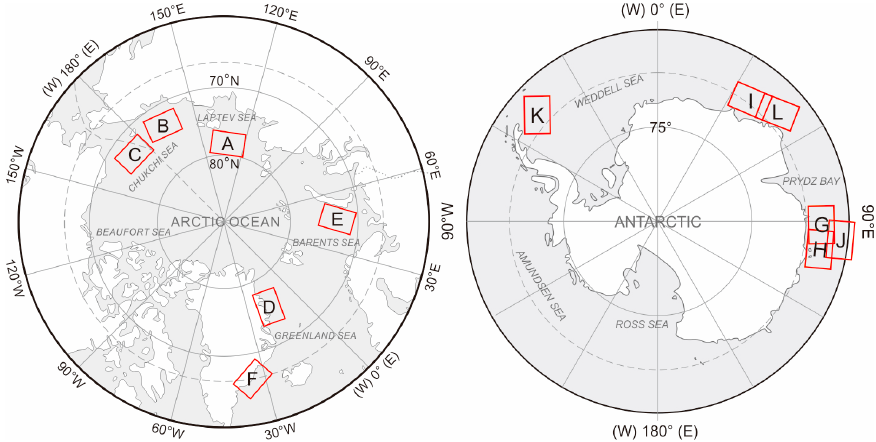
Figure 1. Location of the twelve moderate ‐ resolution imaging spectrometer (MODIS) scenes in Arctic and Antarctic. and Antarctic. Table 1. Times of the twelve MODIS scenes in the Arctic and Antarctic. Table 1. Times of the twelve MODIS scenes in the Arctic and